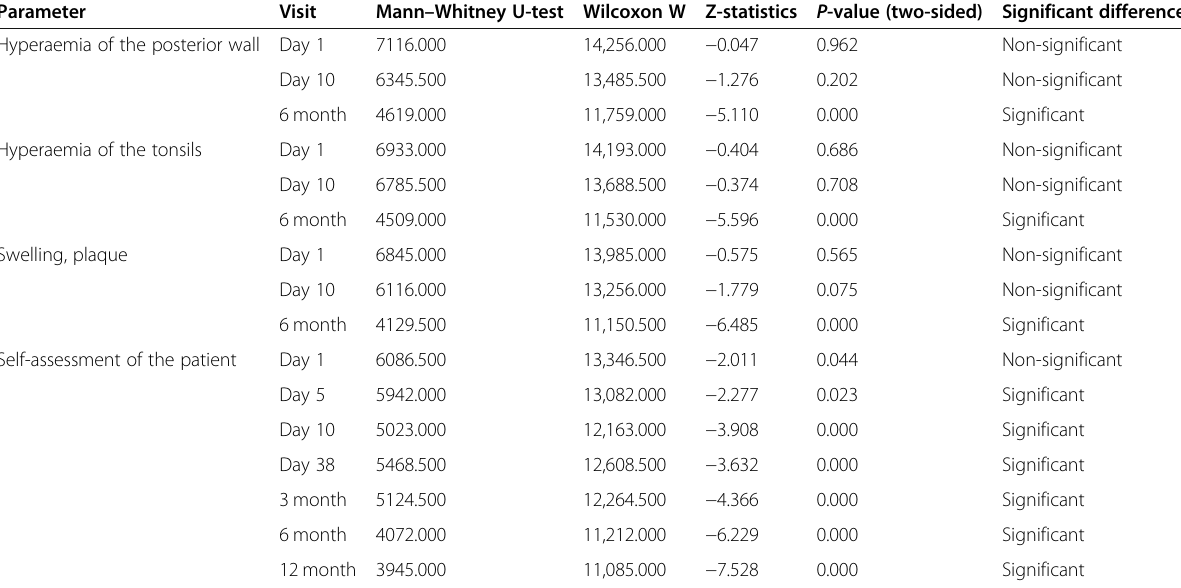
Table 5 The comparison of the groups according to the dynamics of the symptom severity using the Mann – Whitney U-test Parameter Visit Mann – Whitney U-test Wilcoxon W Z-statistics P -value (two-sided) Significant differences a Hyperaemia of the posterior wall Day 1